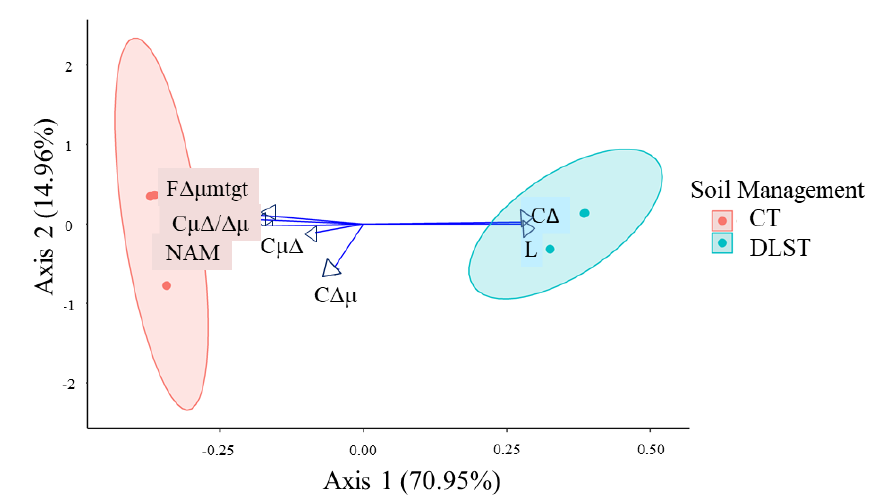
Figure 4. Principal component analysis (PCA) based on the areas of structures in a dystrophic Red-Yellow Latosol under conventional tillage (CT) and deep localized soil tillage (DLST). Organization of clods: L = free soil volume, C = continuous soil volume, F = cracked soil volume, NAM = unaltered soil volume by use and management, mt = medium clods (7 cm Ø), gt = large clods (10 cm Ø). Internal states of clods: μΔ = porous with indications of compression, μΔ/Δμ = medium porosity, Δμ = compact with some porosity, Δ = compact with no visible porosity to the naked eye.